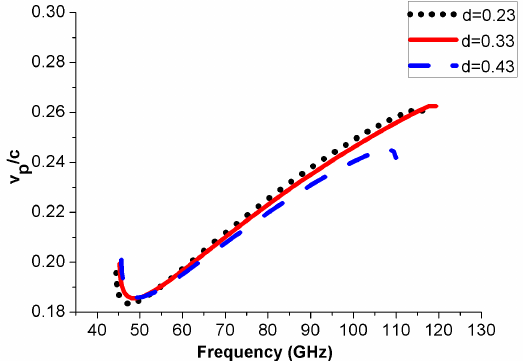
Figure 3. Normalized phase velocity of the CV-FWG for various values of d .